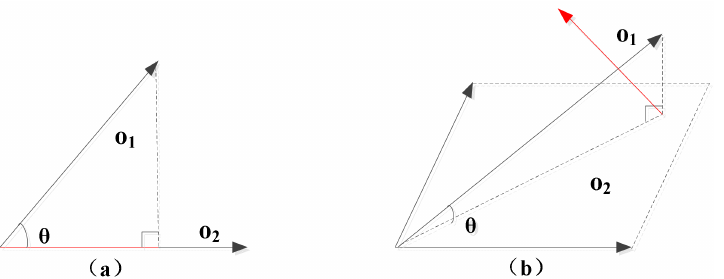
Figure 15. Inner product. ( a ) Inner product between two vectors; ( b ) Inner product between one vector and one